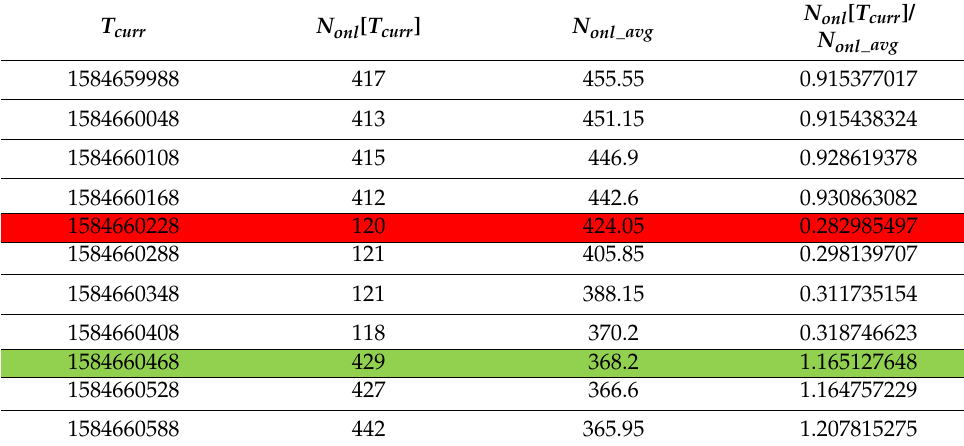
Table 1. Failure detection and resolution example. T